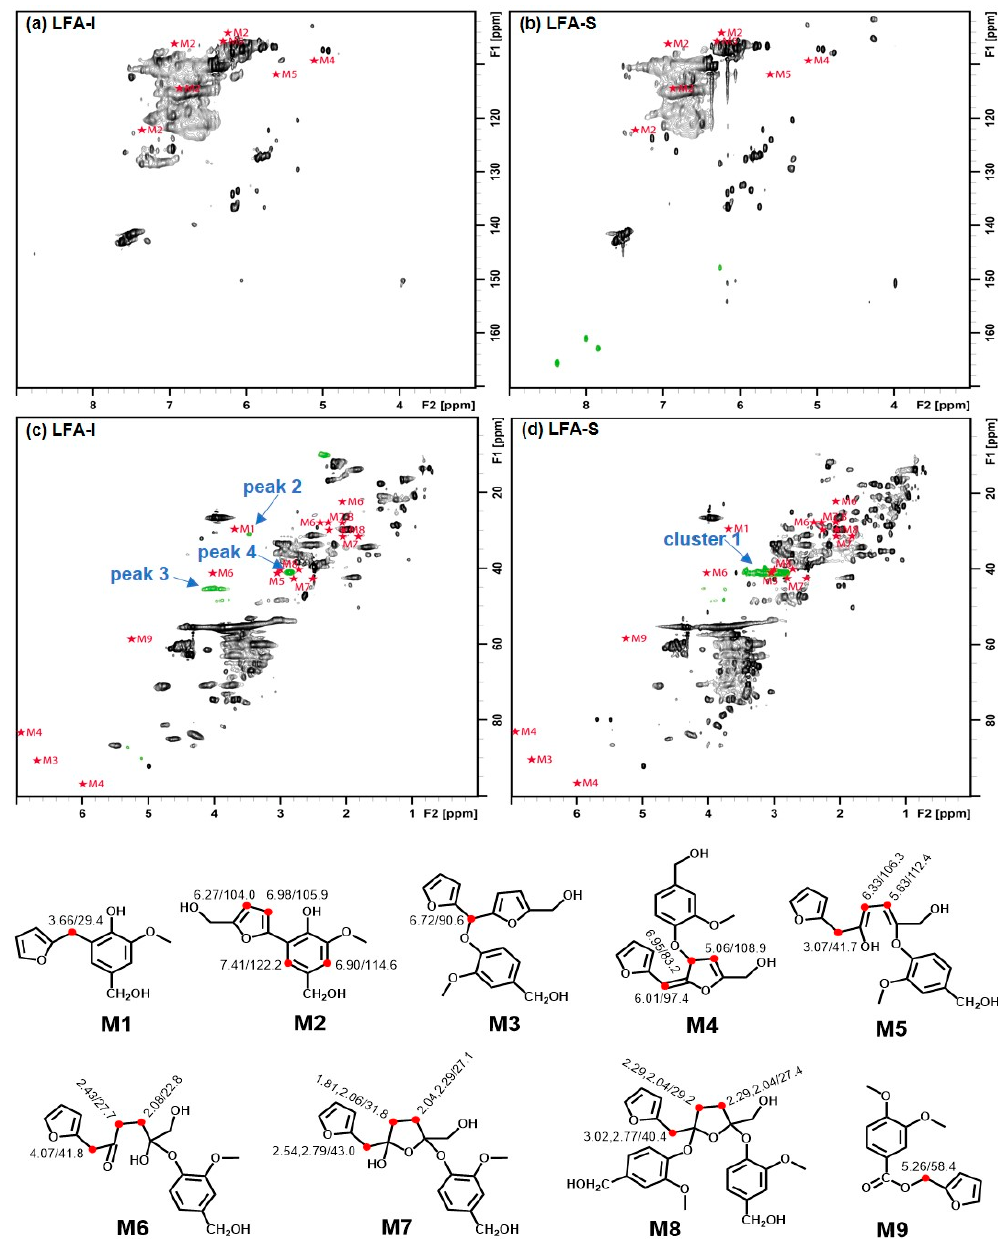
Figure 7. HSQC spectra of LFA fractions overlaid with simulated CS for models M1–9, ( a ) aromatic region of LFA ‐ I, ( b ) aromatic region of LFA ‐ S, ( c ) aliphatic region of LFA ‐ I, ( d ) aliphatic region of LFA ‐ S.